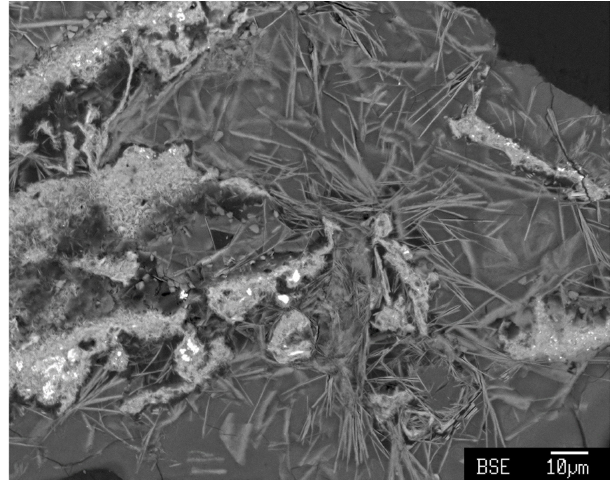
Figure 3. Backscattered electron image showing ultra-thin platelets of tomsquarryite in an amorphous CaMgAl phosphate matrix in Penrice quarry specimen G35031.